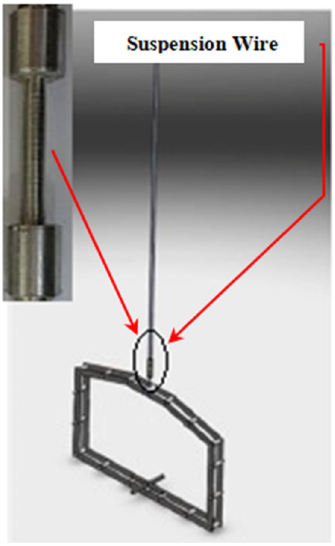
Fig. 4. previous weighing pan.